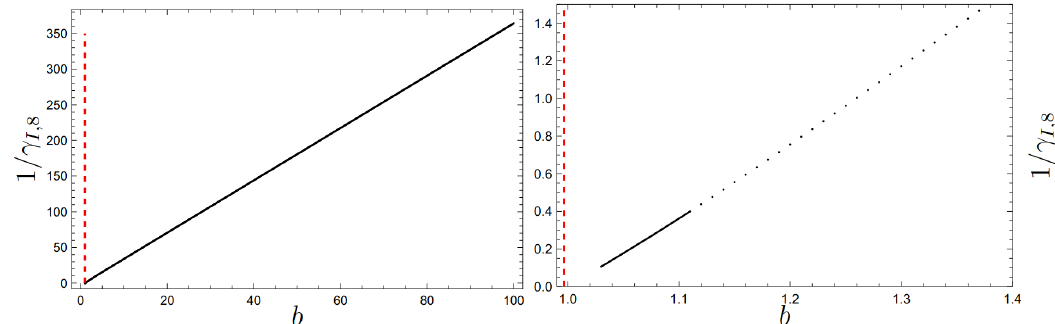
Figure 9 . Thermal conformal order parameter γ 8 ≡ T − 8 hO 8 i of the deformed Model III diverges as b → b + 0 , represented by the dashed vertical red line. crit ,III